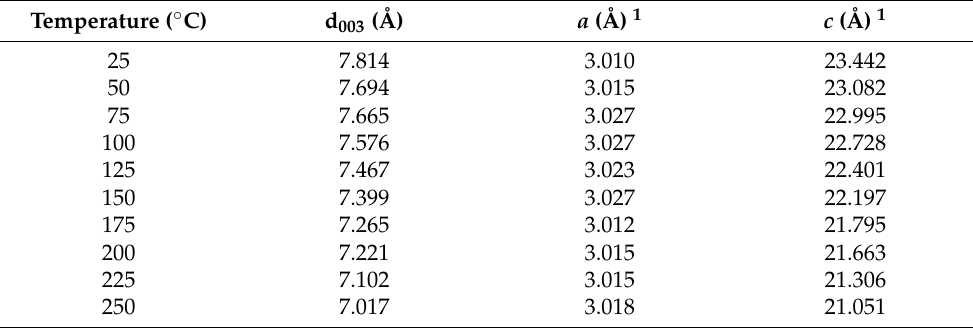
Table 2. Evolution of lattice parameters of Ni 3 Fe-LDH as a function of temperature. Temperature ( ◦